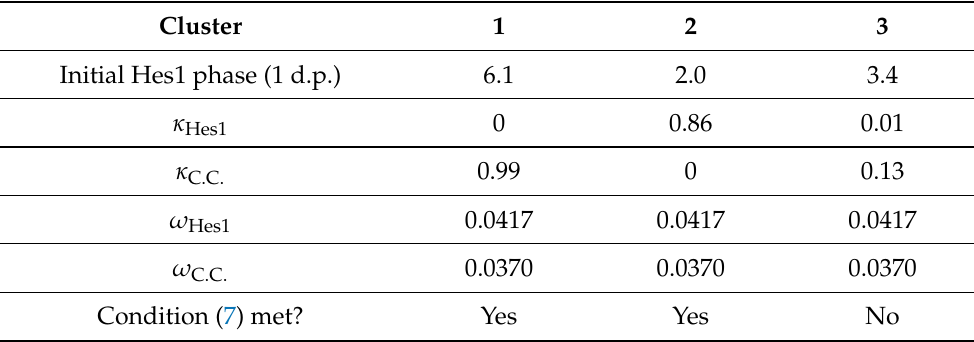
Table 2. Table summarizing the optimal κ Hes1 and κ C.C. values for the model Equation (5) for each cluster